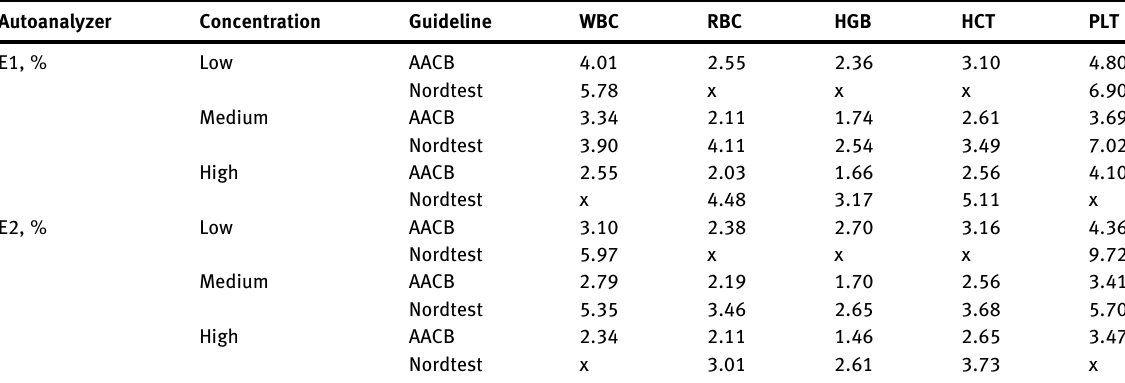
Table  : Beckman Coulter DXH-  complete blood count autoanalyzers measurement uncertainty percentages. Autoanalyzer